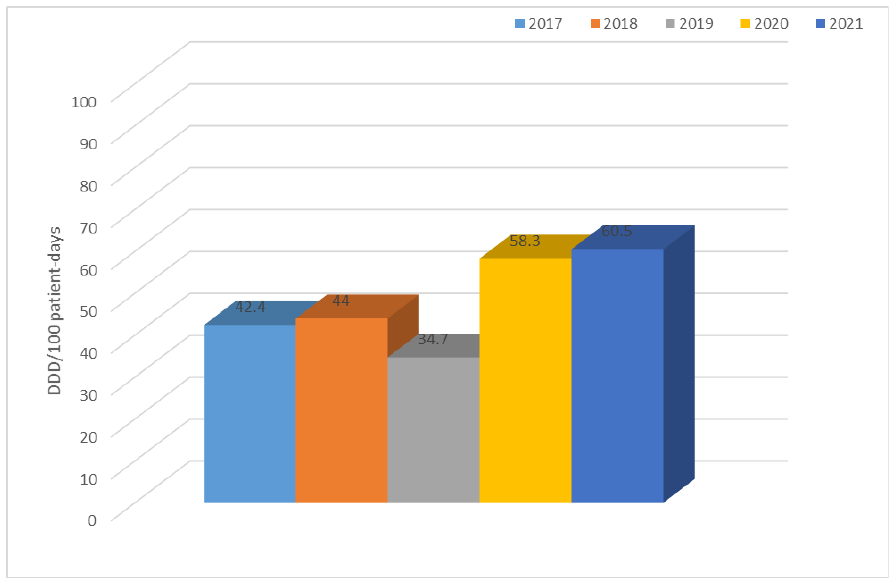
Figure 23. Consumption of antibiotics in all departments of the hospital over the past five years. Analysis of the use of antibiotics from different groups showed a clear increase in